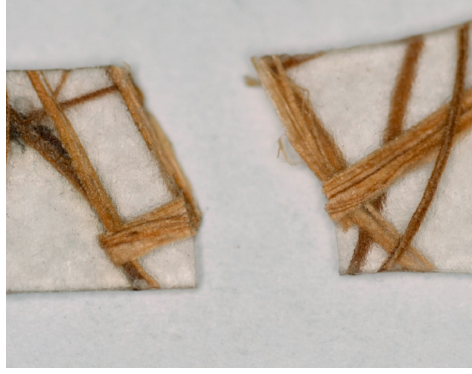
Figure 5. Photograph of a representative fractured RANDOM composite.